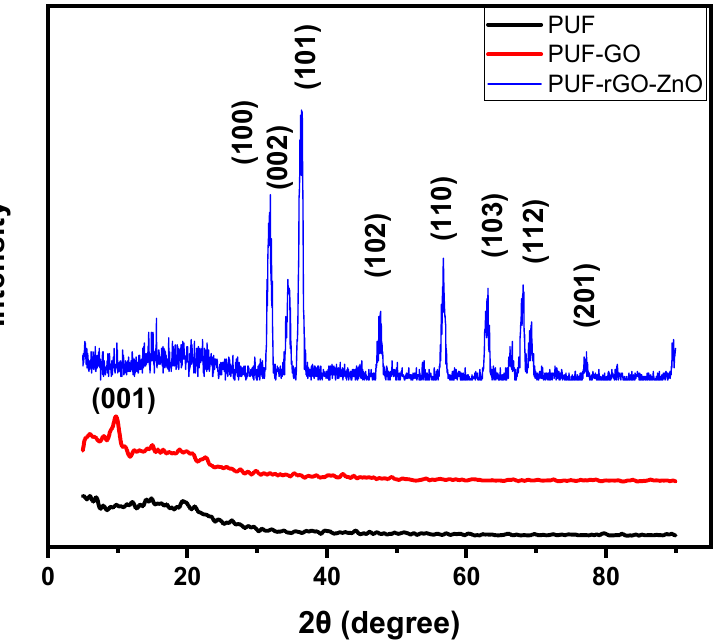
Figure 1. XRD patterns of neat PUF, PUF/GO, and PUF/rGO/ZnO nanocomposites. The diffraction peaks are consistent with card No. 01-078-3322 which has been assigned to ZnO NPs. It was observed that the diffraction peaks of GO nanosheets disappeared, confirming the reduction of GO. Moreover, impurities were not detected in the diffraction patterns, supporting the purity of the synthesized structure. The average crystallite size of ZnO NPs was estimated from the well-known Scherrer equation [35] D = where D is the average crystallite size in nm, k is the shape factor, β D is the full width at half maximum (FWHM), and θ is the diffraction angle. The estimated average crystallite size was found to be about 15